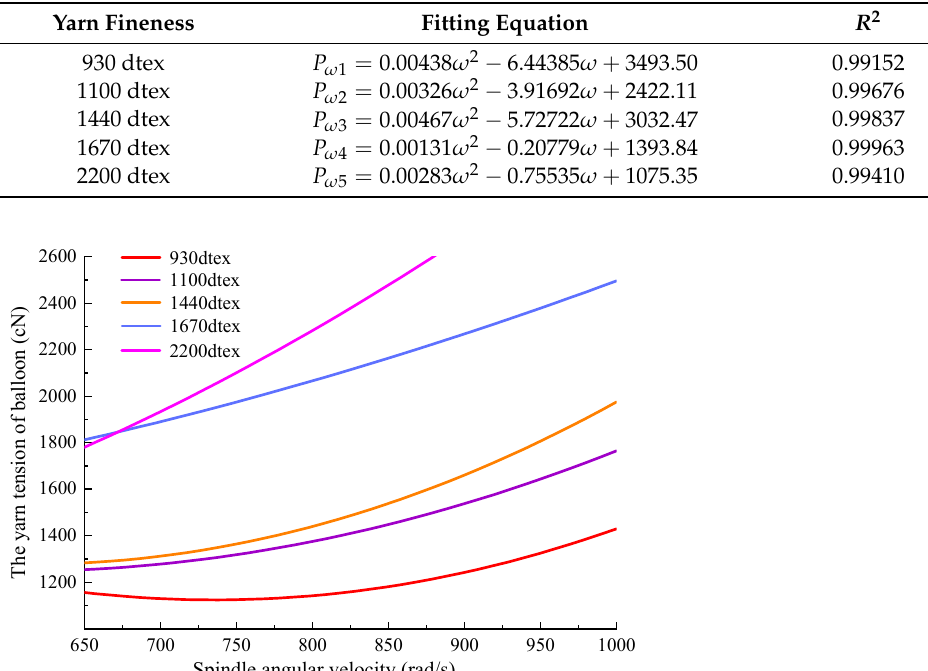
Table 3. Measurement values of twisting tension under different yarn fineness and spindle angular velocity. Twisting Configu- Spindle Angular Veloc- Experimental Item ration ity (rad/s)